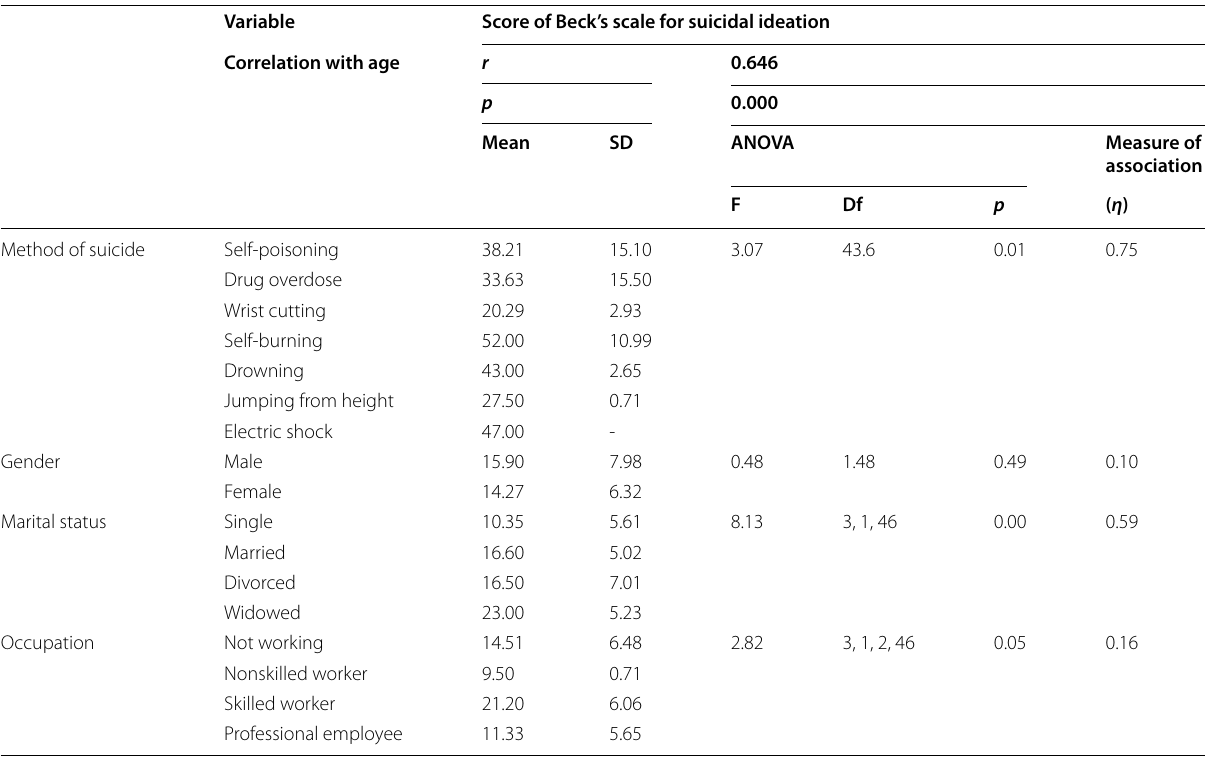
Table 3 Association between score of Beck’s scale for suicidal ideation and psychosocial